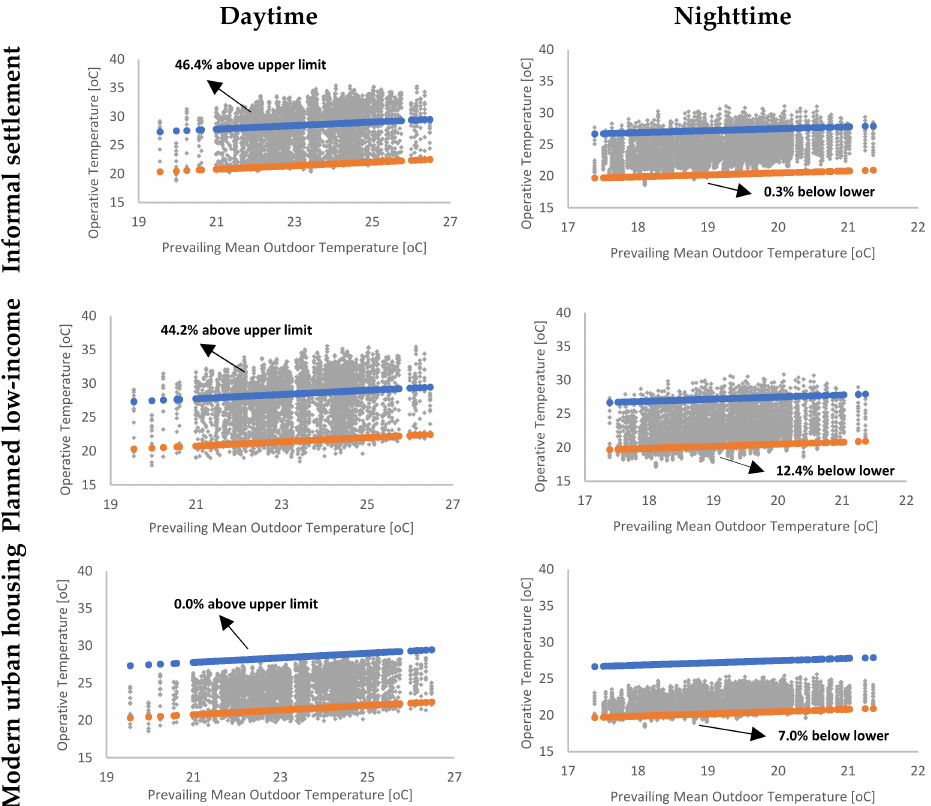
Figure 4. Predicted hourly operative temperature and adaptive comfort